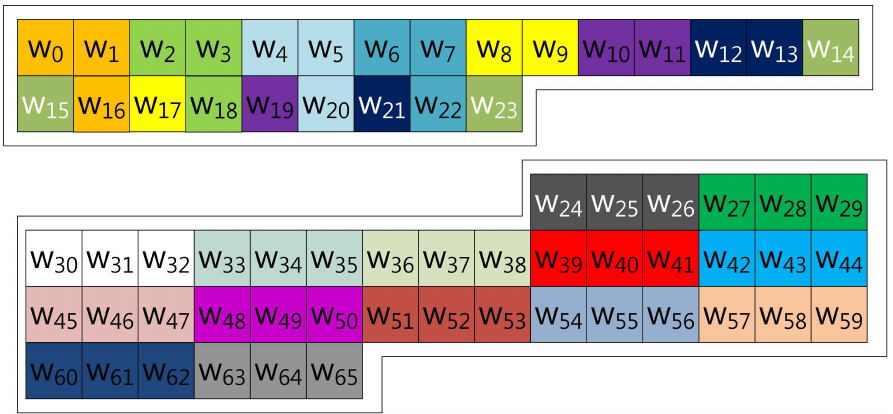
Figure 10. Look-up table structure of the (hybrid) proposed method in block form for 3NAF (version